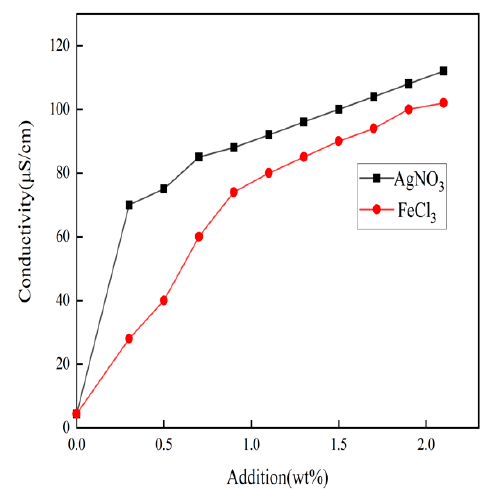
Figure 1. Electrical conductivity of PVDF/AgNO 3 and PVDF/FeCl 3 ·6H 2 O solution.